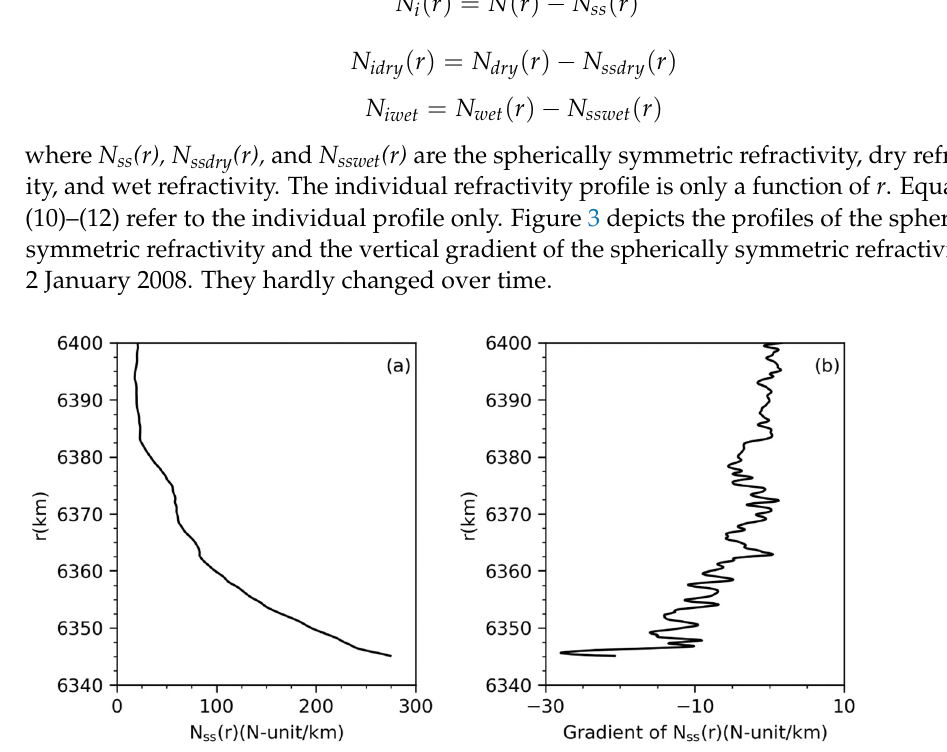
Figure 3. ( a ) The spherically symmetric refractivity and ( b ) vertical gradient profiles on 2 January